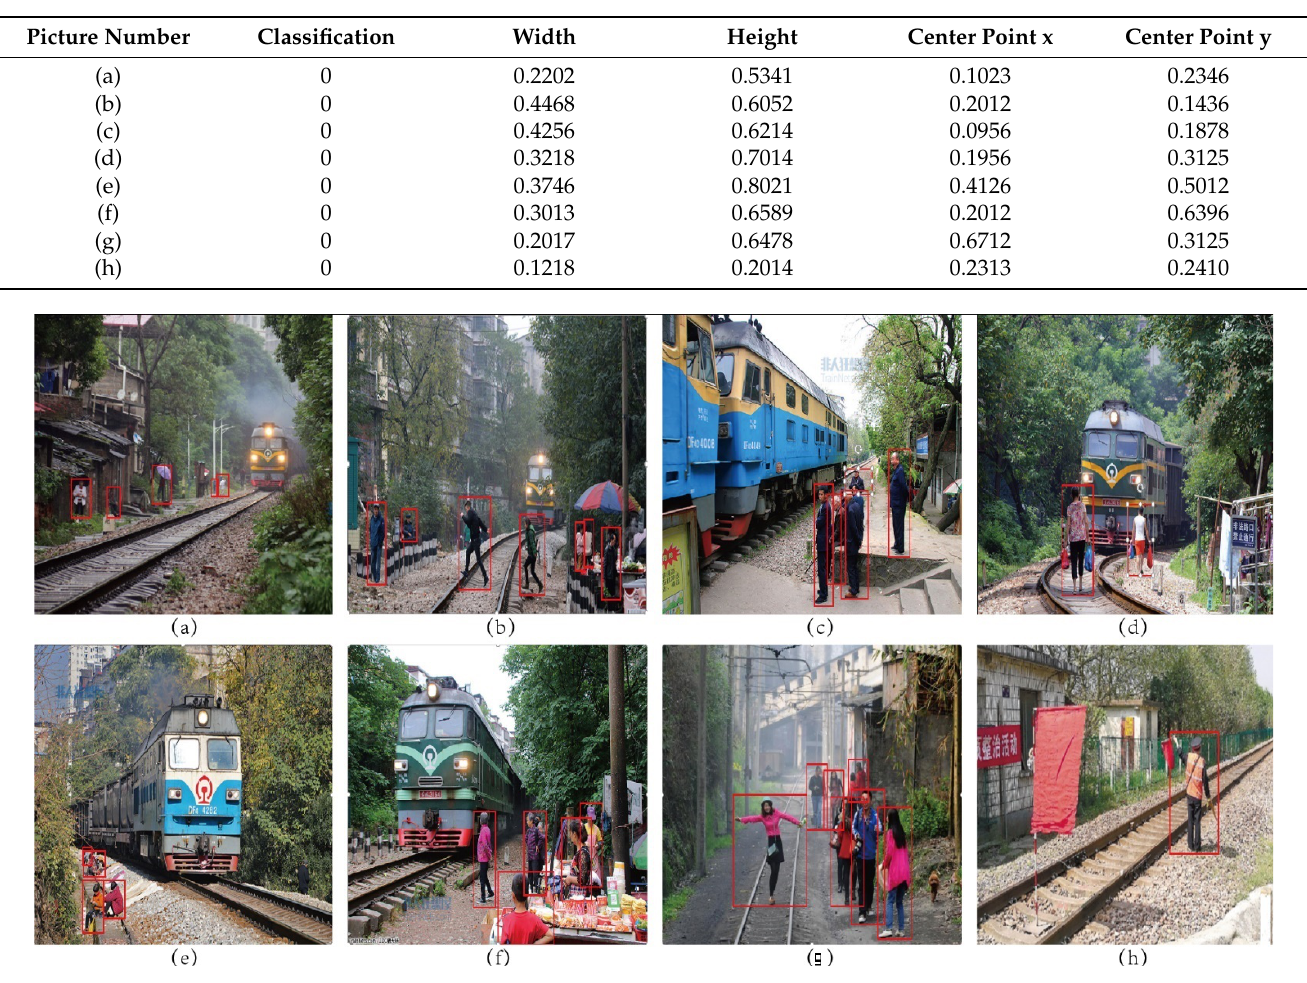
Table 1. Information of annotated data.